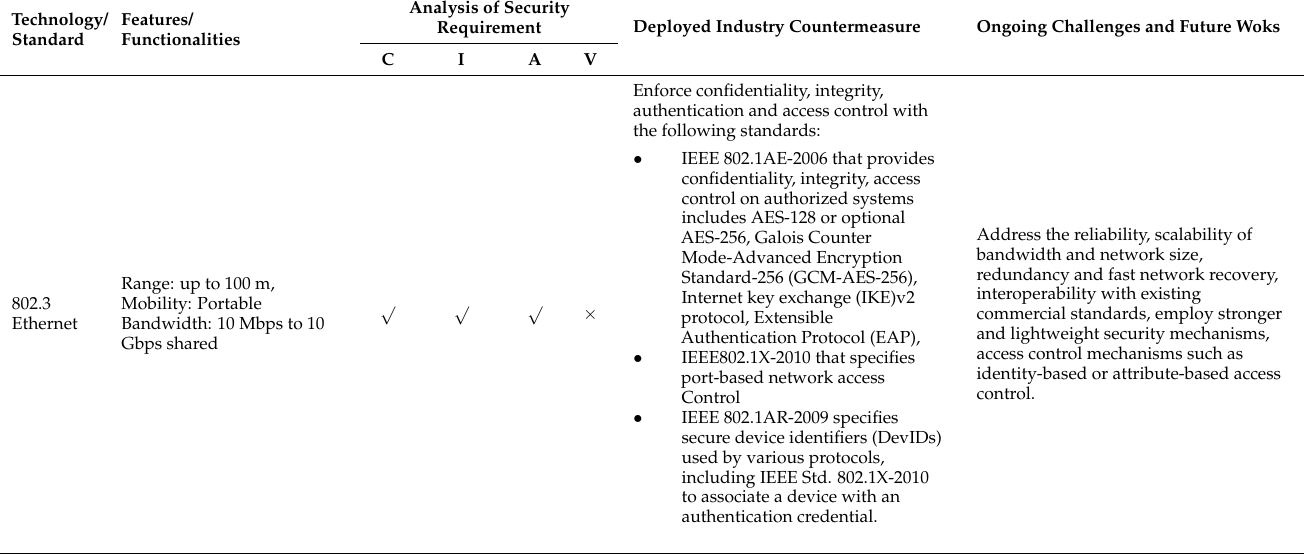
Table 8. Security analysis on backhaul network and communication